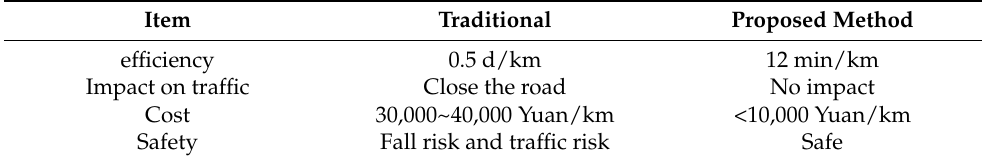
Table 2. Comparison of